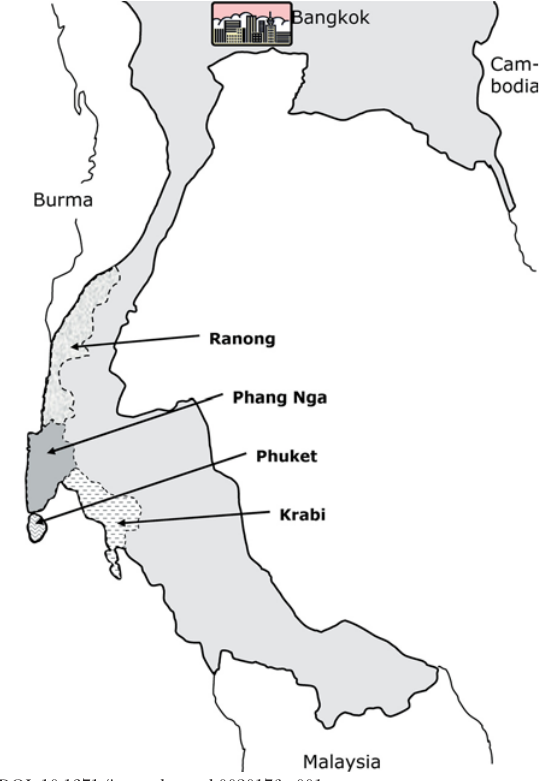
Figure 1. Four Provinces of Southern Thailand Most Severely Affected by the Tsunami (Source: Thai Ministry of Interior Department of Disaster Prevention and